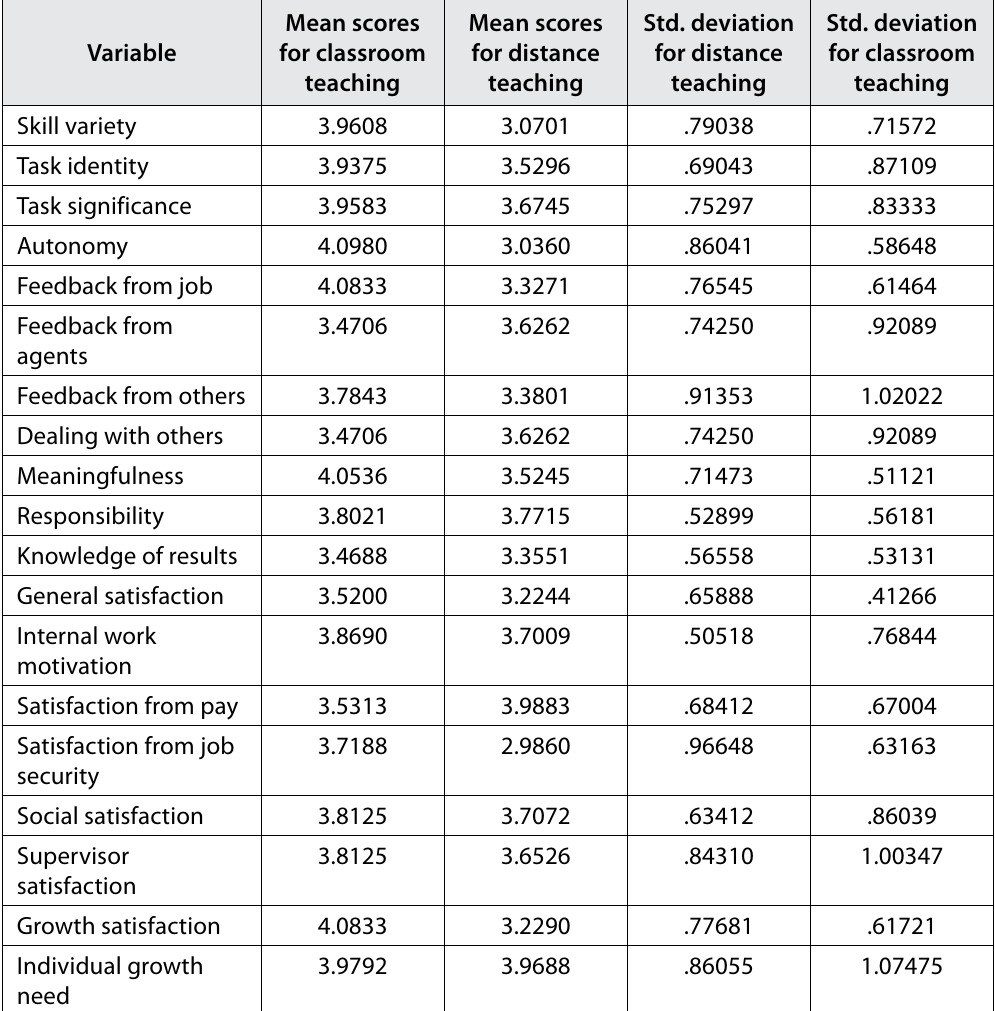
Table 1 Comparison of mean